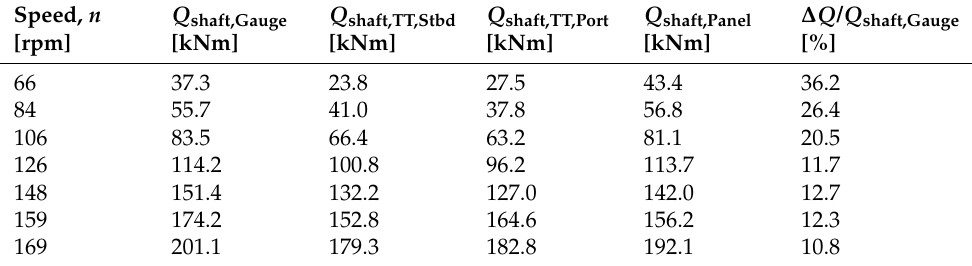
Table 3. Torque values from the different sources, for seven speed levels.